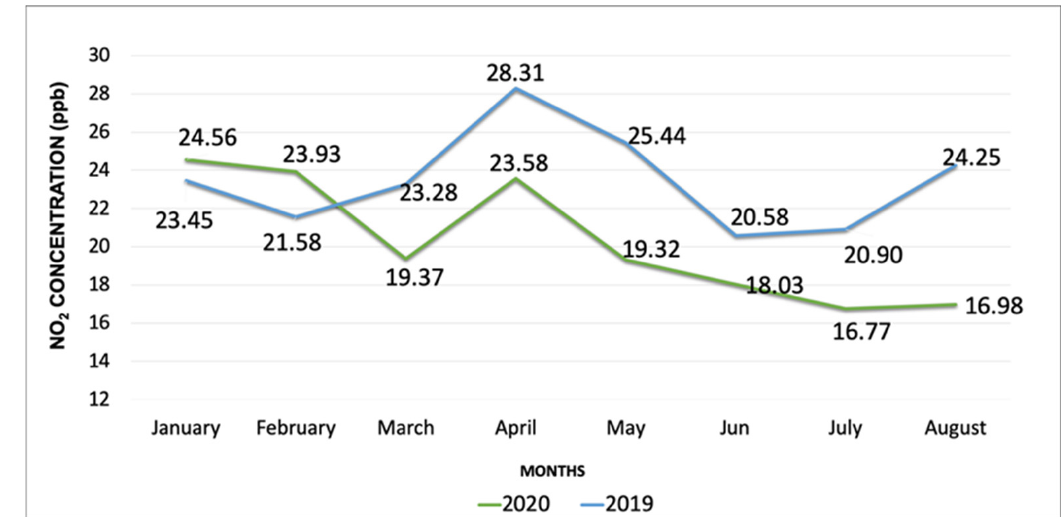
Figure 4. Variation in monthly mean NO 2 concentrations (ppb) from January to August in 2019 and 2020.